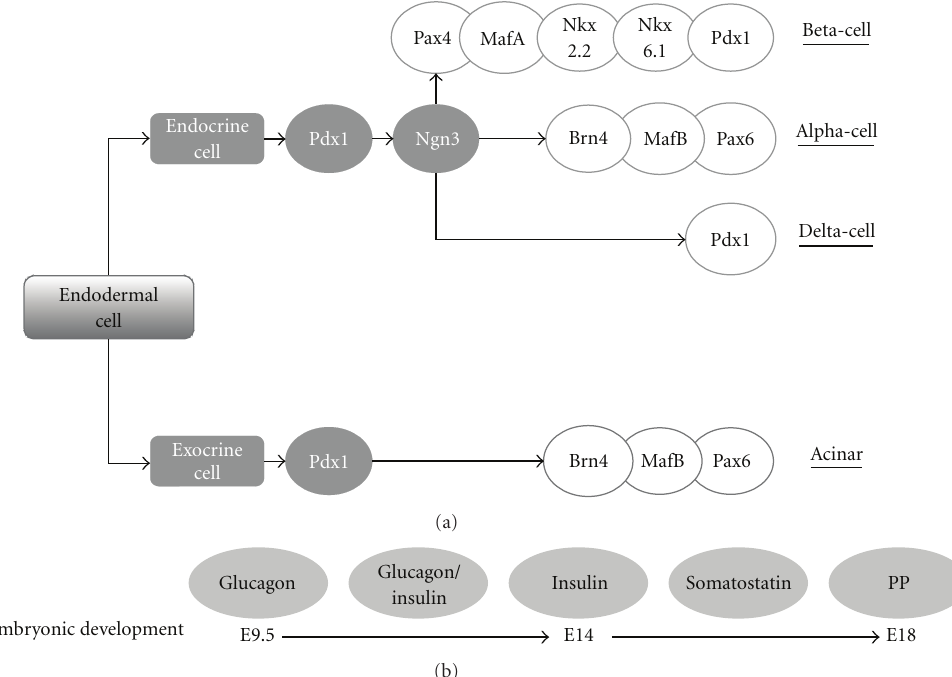
Figure 1: Regulation of pancreatic development. (a)Pancreatic cells (both endocrine and exocrine) originate from the samePdx-1 expressing endodermal cells. The transcription factor Ngn3 is required for di ff erentiation into an endocrine phenotype. Further development into insulin-, glucagon-, or somatostatin-secreting cells is tightly regulated by a range of transcription factors as indicated in the figure. Pax, NKX, Pdx-1, and Brn4 are homeodomain proteins which are generally involved in morphogenesis, while MafA and MafB are members of the large Maf protein family which regulates pancreatic development. (b) Timescale showing emergence of islet hormone-producing cells in the rodent